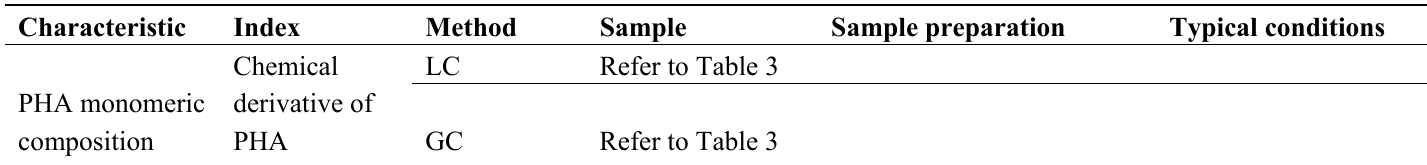
Table 6. Techniques for PHA polymer